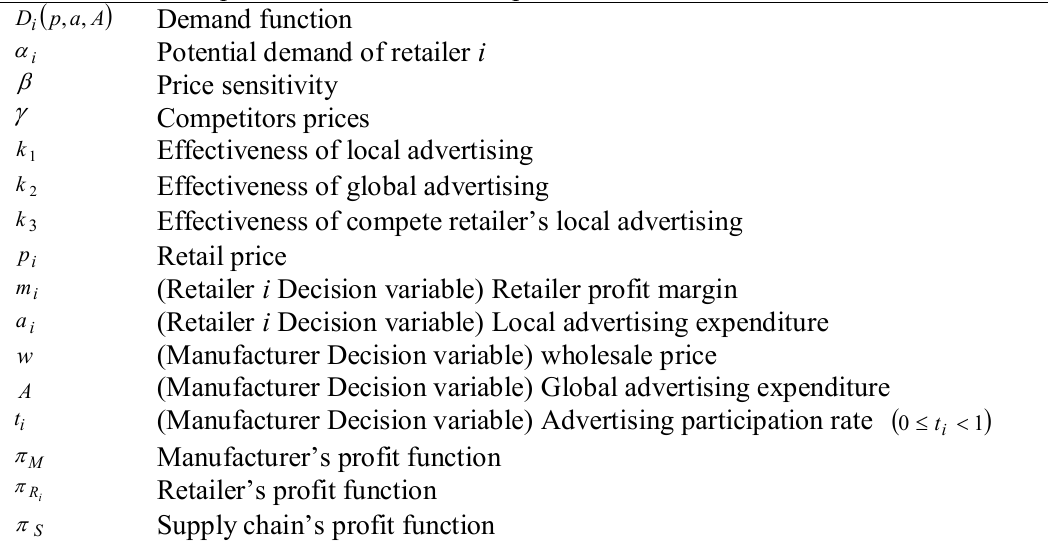
Notation for monopolistic-manufacturer duopolistic-retailers